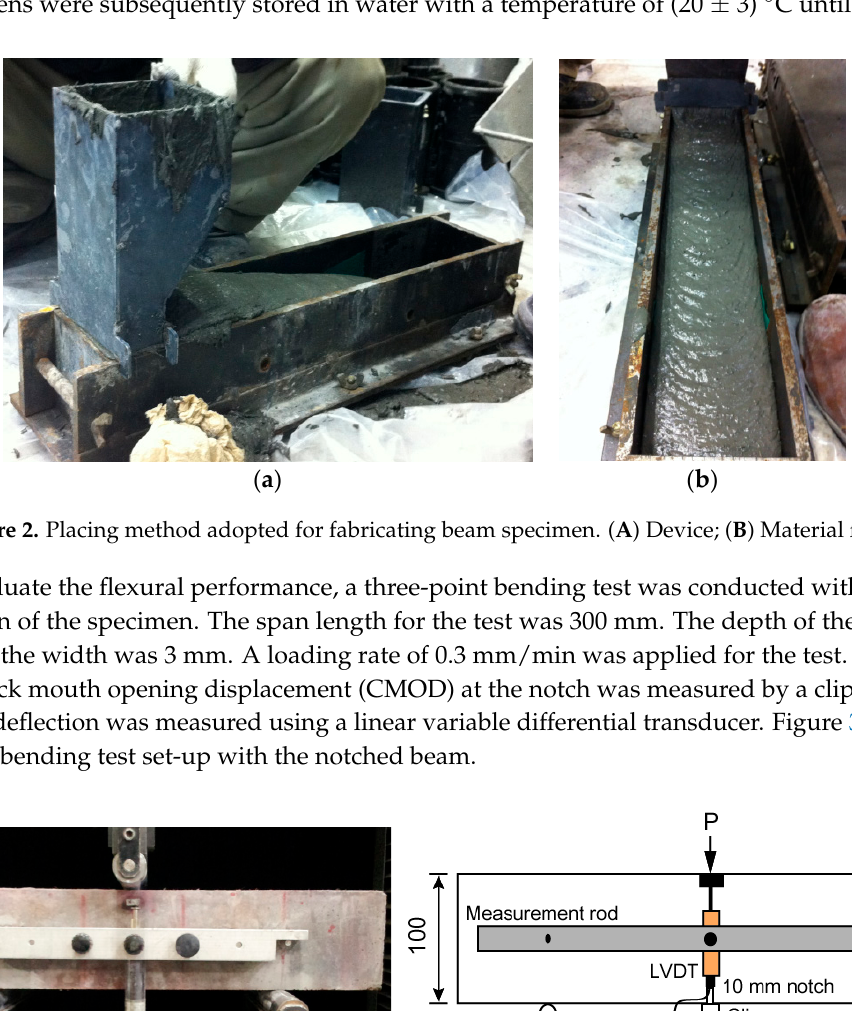
Figure 3. Set-up of three-point bending test with notched beam. ( a ) Test setup; ( b ) Dimensions.